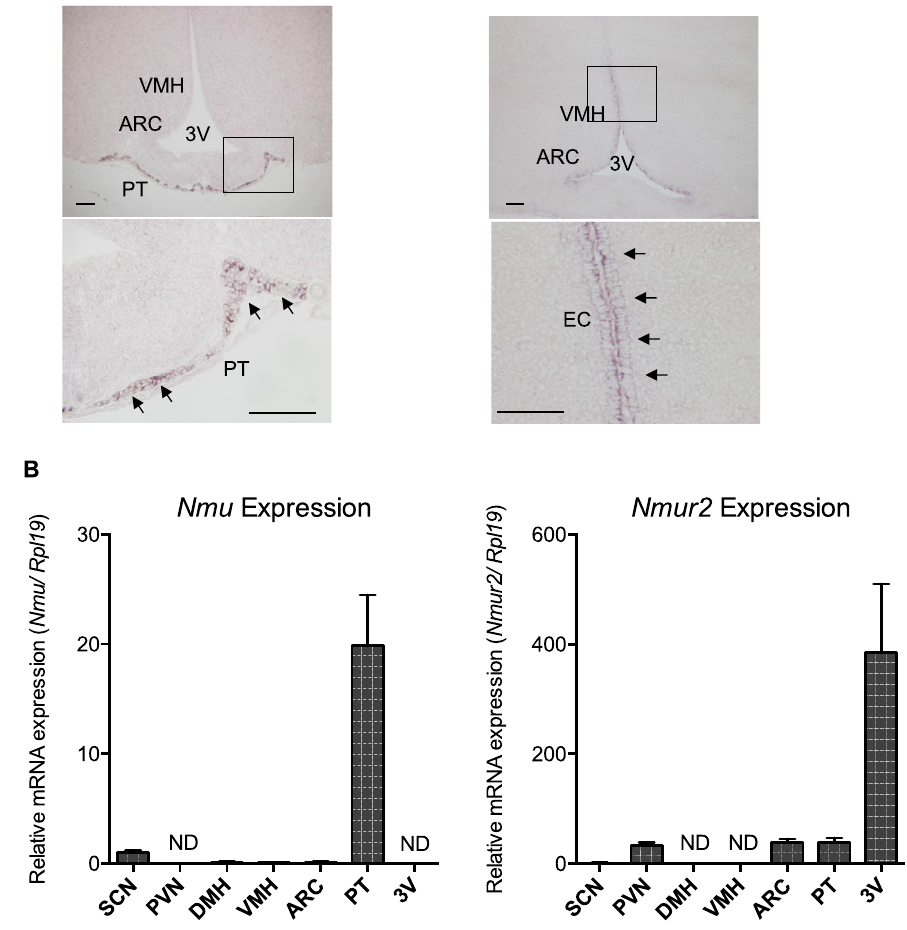
Figure 8. Expression of Nmu and Nmur2 in WT rats. ( A ) Localization of Nmu and Nmur2 mRNA expression determined by ISH in the rat brain. Representative microphotographs of ISH staining with DIG-labeled cRNA probes in a frontal section of the WT rat brain. Positive signals are indicated by arrows in magnified images (lower). Scale bar: 100 µm. VMH, ventromedial hypothalamic nucleus; ARC, arcuate nucleus; PT, pars tuberalis; 3 V, third ventricle. EC, ependymal cell layer of 3 V. ( B ) RT- qPCR analysis of Nmu and Nmur2 expression in the SCN, PVN, DMH, VMH, ARC, PT, and EC using LMD samples. All data represent means ± SEM (WT n = 6 KO n = 5). ND indicates no signal detection. See also Supplementary Figure